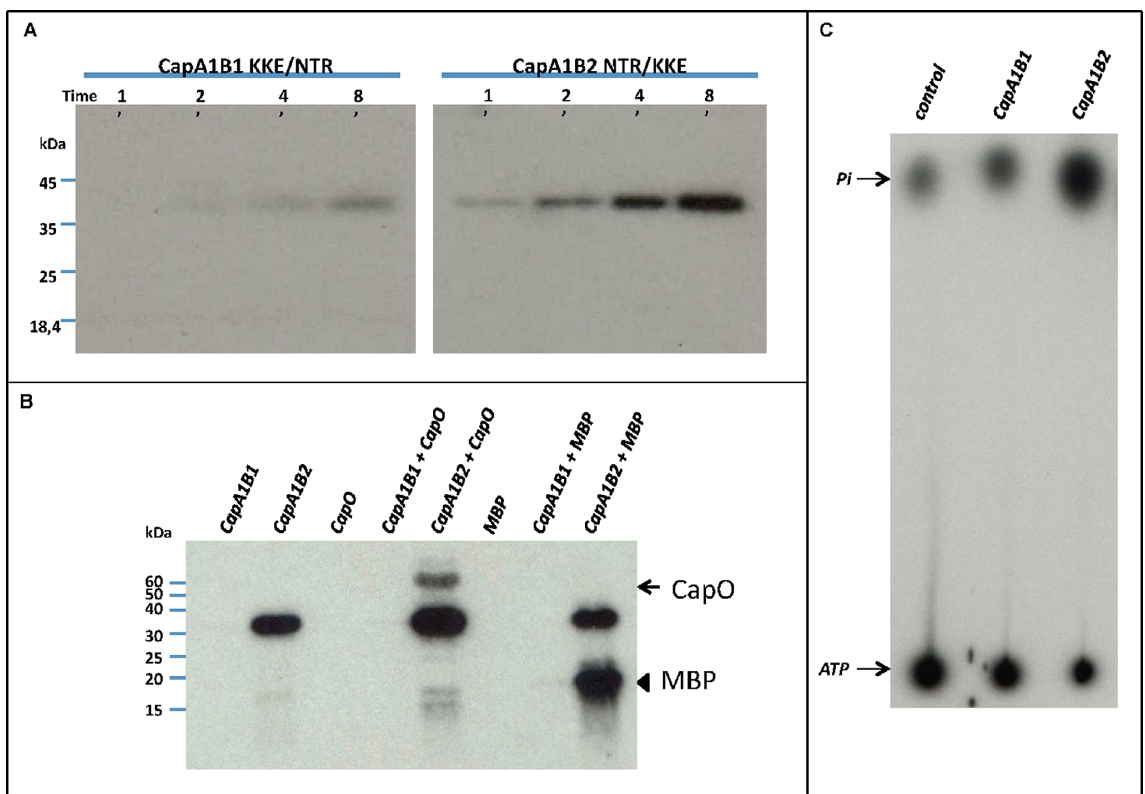
Figure 6. CapA1B1 activity assays. A – Effect of CapB2 N3T4R5 substitution for CapB1 K3K4E5 and vice versa on CaB1 and CapB2 kinase activity. CapA1B1(KKE/NTR) (left panel) and CapA1B2(NTR/KKE) (right panel) were incubated in the presence of radioactive ATP for either 1, 2, 4 or 8 minutes. After SDS-PAGE analysis, their autophosphorylation was visualized by autoradiography. B – CapO and myelin-binding protein (MBP) phosphorylation assays. The ability of CapA1B1 and CapA1B2 to phosphorylate CapO or the myelin-binding protein (MBP) was determined after incubation in the presence of radioactive ATP, SDS-PAGE analysis and film exposure. The arrow points to CapO whereas the arrowhead shows the MBP. C – ATPase activity of CapA1B1 and CapA1B2. The hydrolysis of [ c -32P] ATP was measured in the presence of either CapA1B1 or CapA1B2 as described under ‘‘Materials and Methods’’. Migration of a control reaction mixture devoid of CapA1B1 or CapA1B2 is also shown.